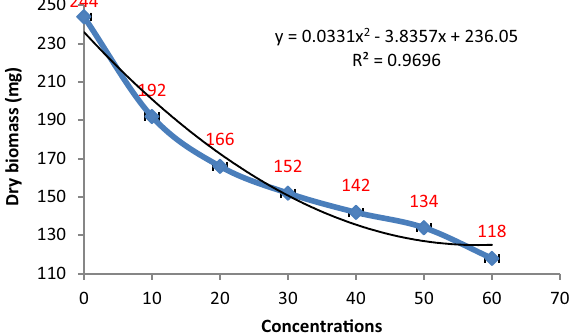
Figure 10. Effect of different metabolite concentrations of P. oxalicum on the biomass production of P. herbarum. Vertical bars show standard errors of the means of three